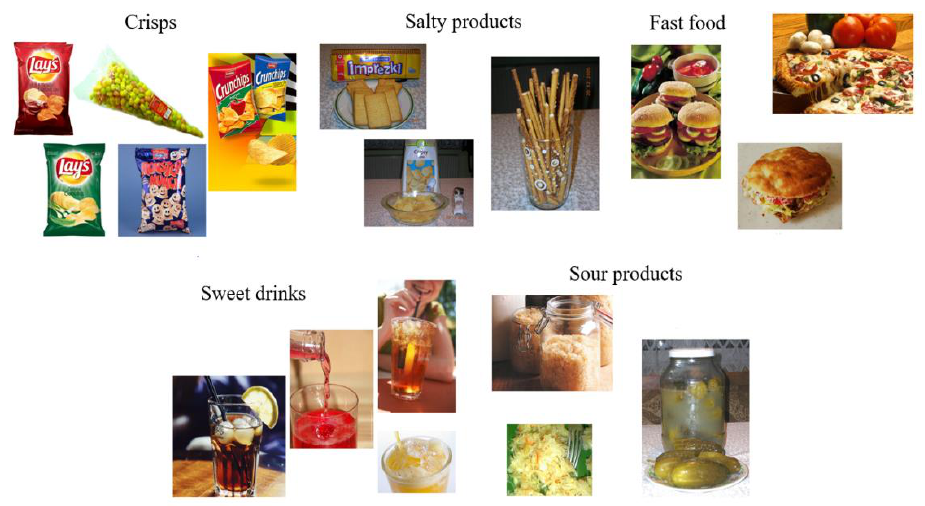
Figure 1. Foods which comprised Factor One—‘unhealthy food with a strong flavour’. Table 2. The values of the declared pleasure of eating various types of dishes, ranging from the most popular ones. Dishes marked in grey are the ones that have been identified by statistical analysis as a common ‘unhealthy food with a strong flavour’ group.